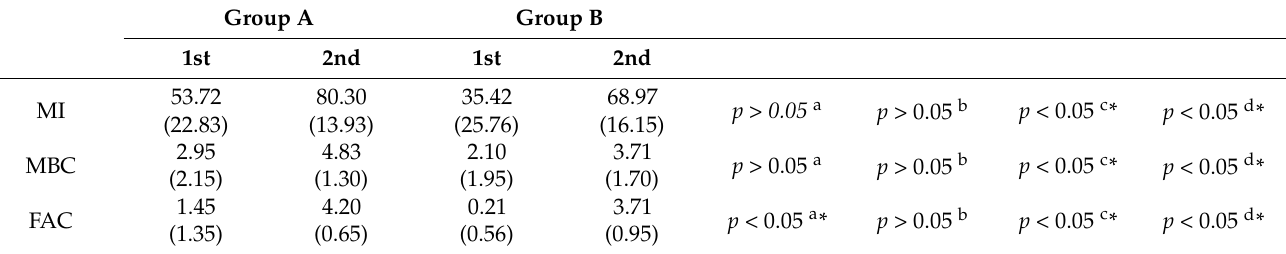
Table 2. Changes in clinical data in groups A and B.